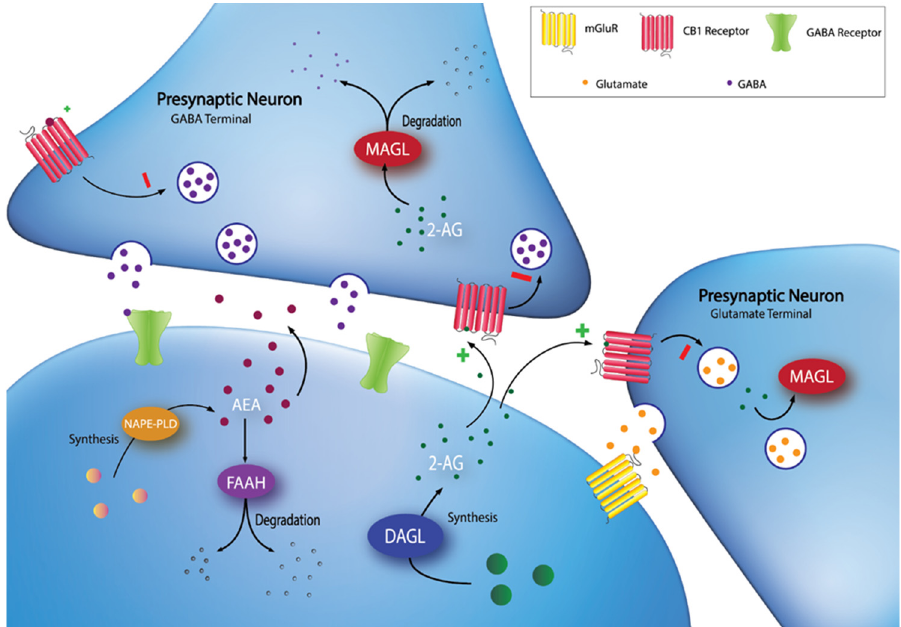
Figure 1. Synaptic localization of endocannabinoid synthesis and degradation. 2-AG is synthesized on-demand in the postsynaptic neuron by DAGL. Following synthesis, 2-AG diffuses into the synaptic cleft and activates CB1 receptors at GABA and glutamate terminals. 2-AG signaling can be terminated by MAGL degradation in the presynaptic terminal. AEA can be synthesized through multiple pathways (e.g., through a pathway involving NAPE-PLD), then diffuses into the synapse to activate CB1 receptors. Extracellular AEA undergoes reuptake into the postsynaptic cell and is hydrolyzed by FAAH.